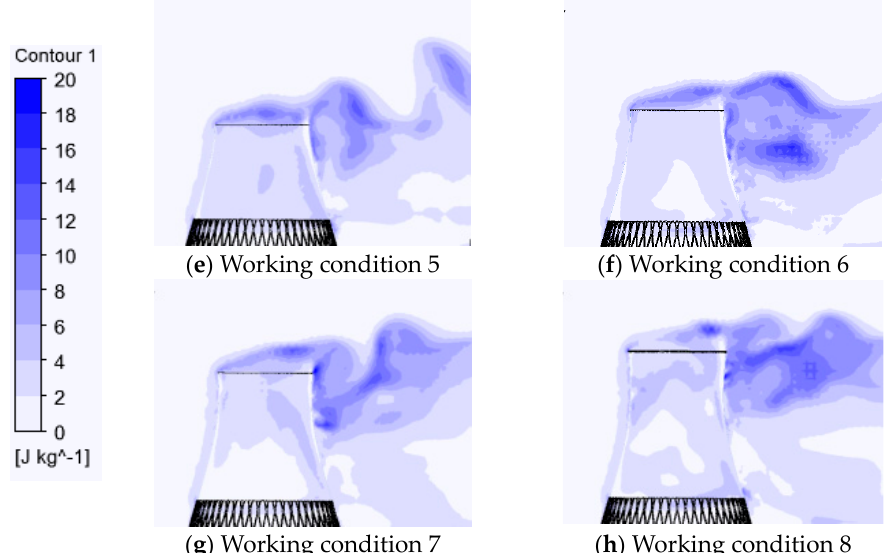
Figure 6. Schematic for turbulent kinetic energy distribution under working condition 8.